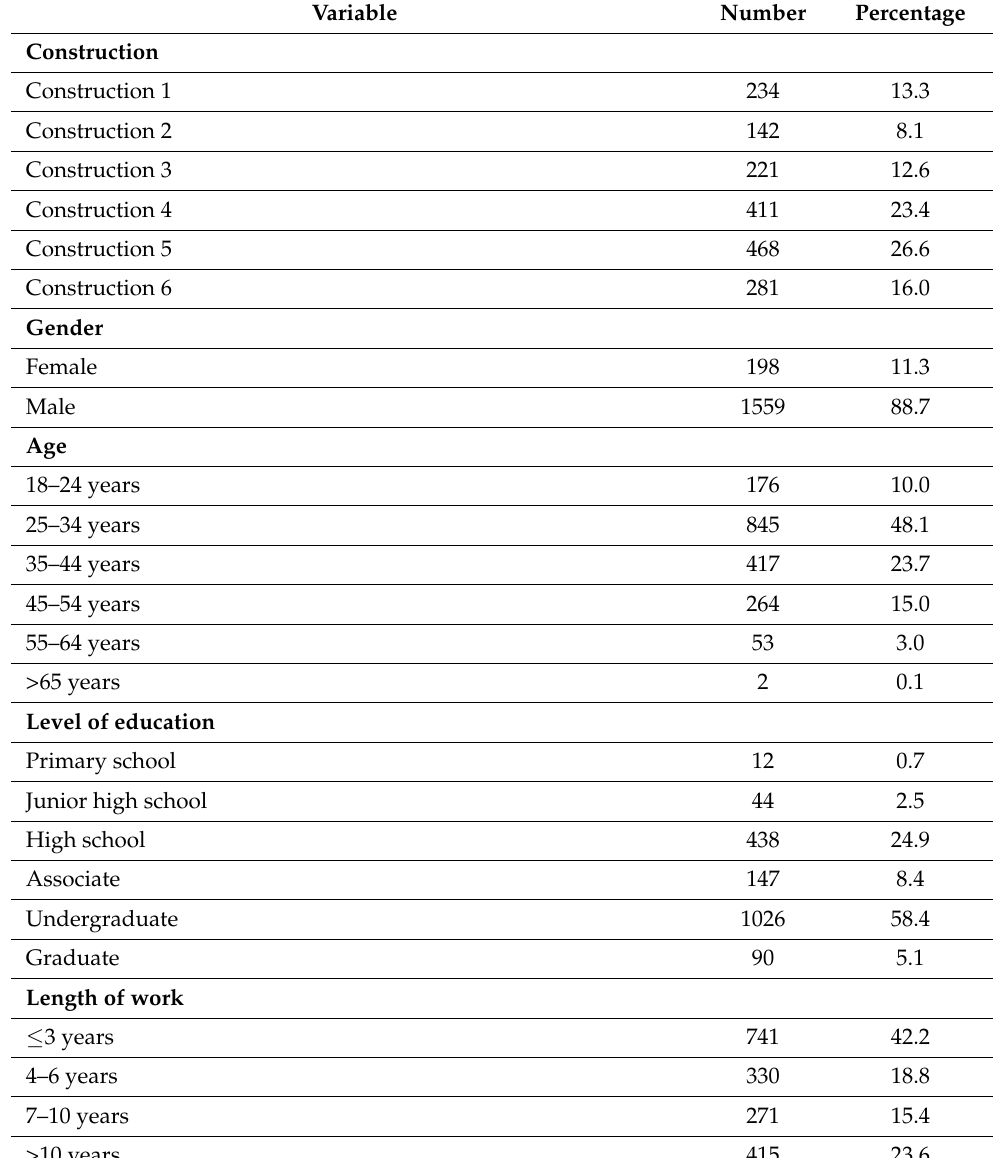
Table 3. Characteristics of